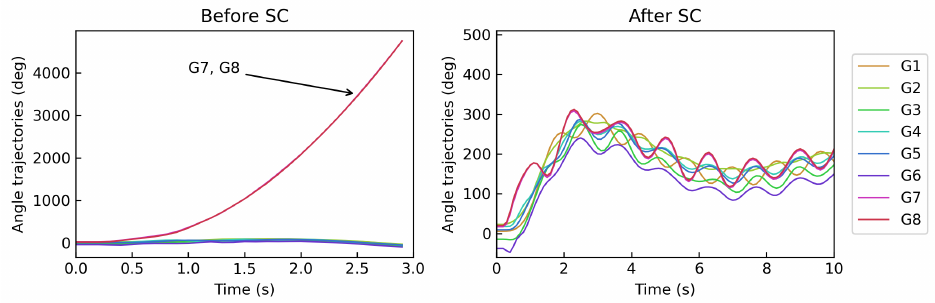
Figure 7. Angle trajectories to a disturbance at 0.2 s before and after implementing